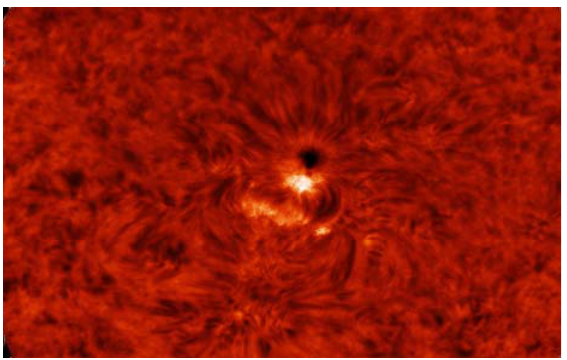
Figure 17. High-Resolution Image of a sunspot Apart from high-resolution imaging, we might consider using the G-band filter as well to observe the Sun in a different